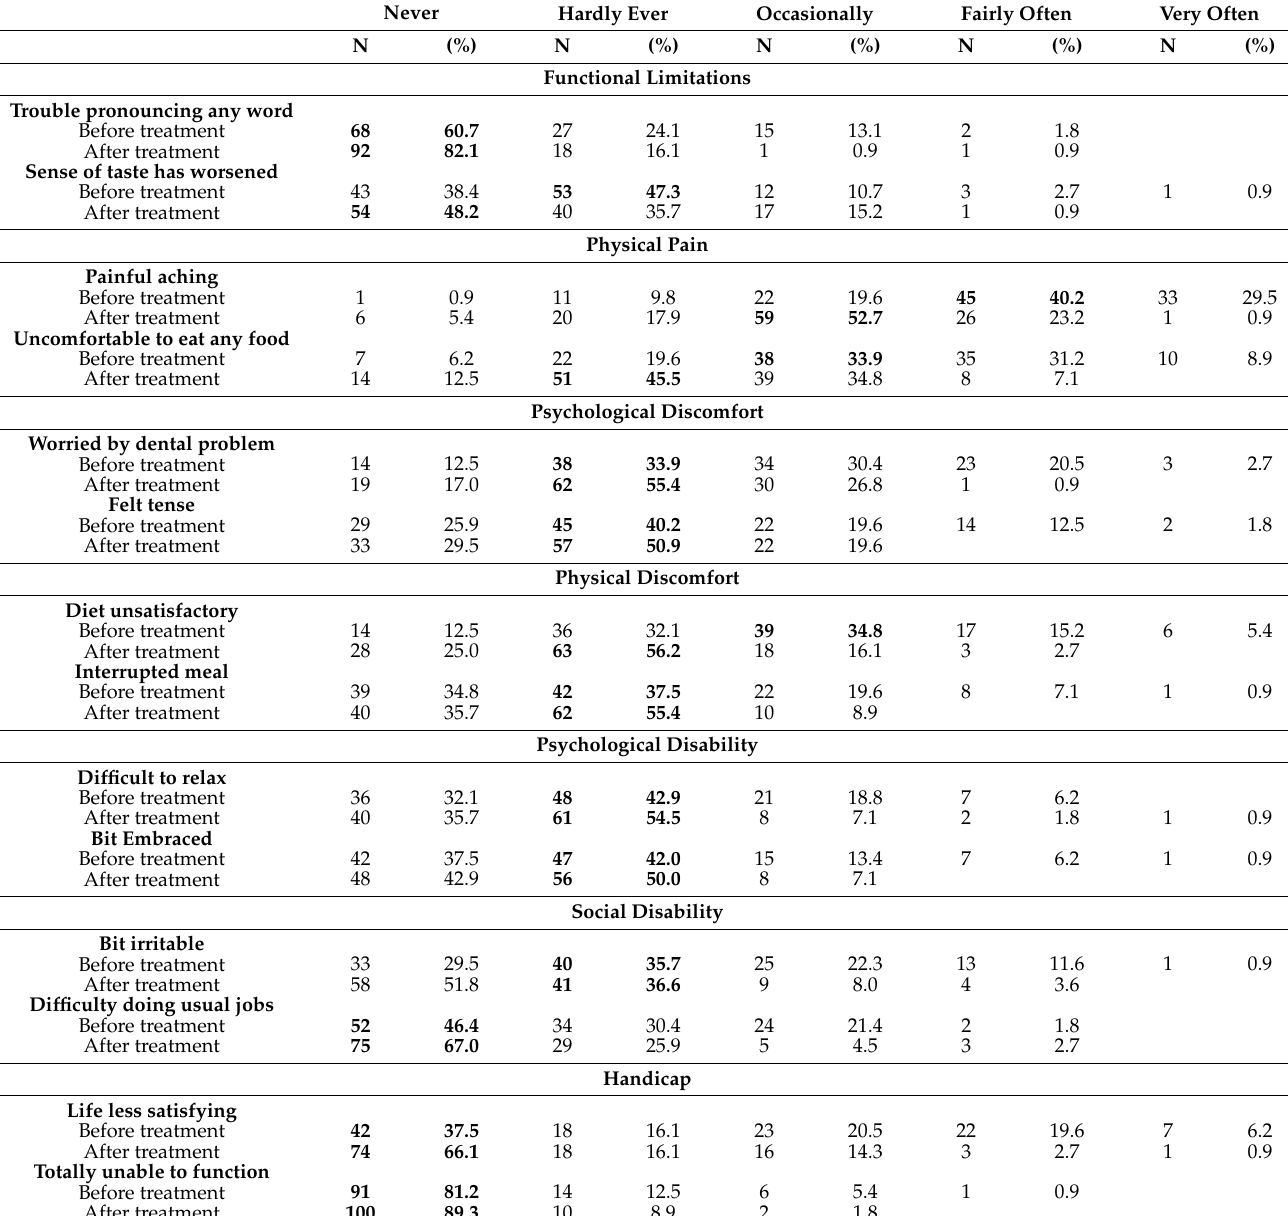
Table 2. Descriptive statistics of quality of life among OSMF patients before and after